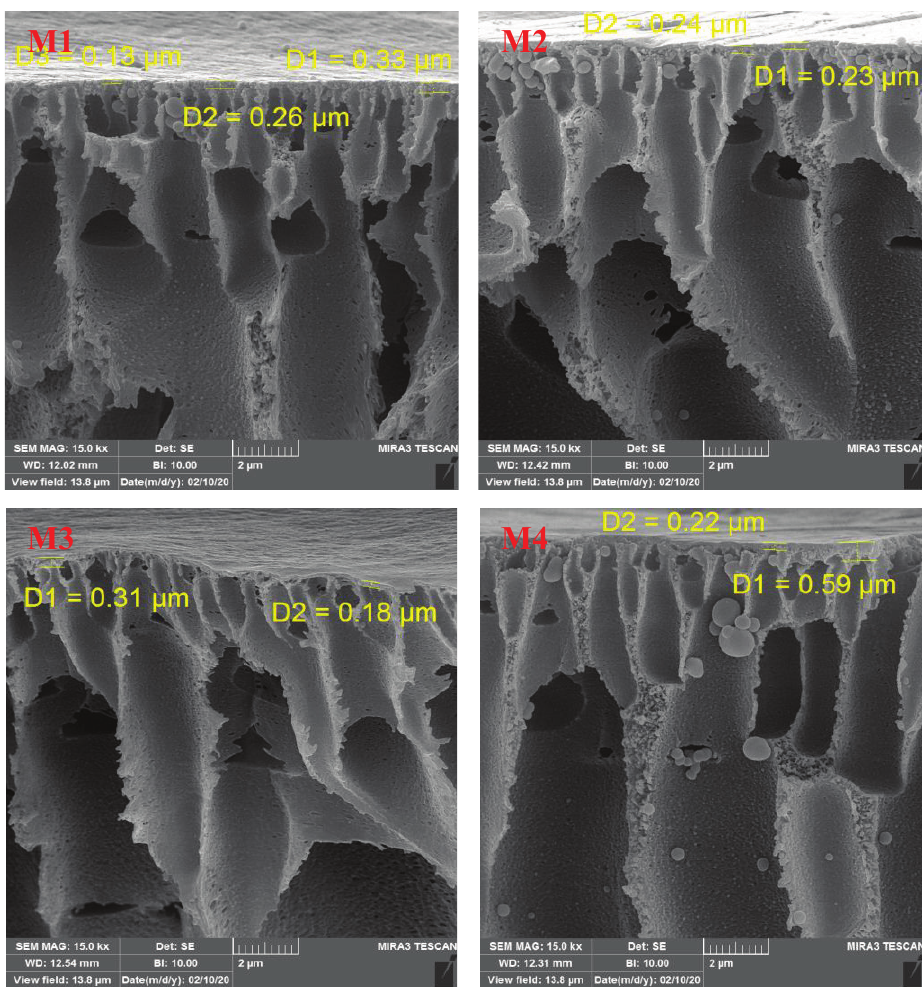
O membranes 2 4